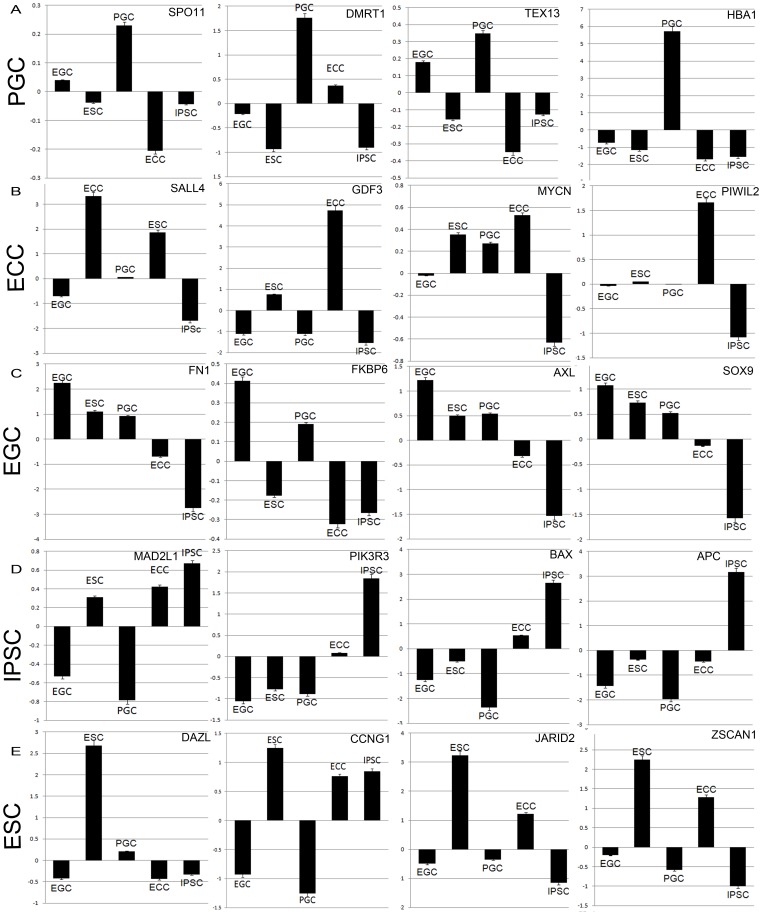
Identification of potential signature genes of PGCs, ECCs, EGCs, IPSCs, and ESCs.The vertical axis of each graph shows the log ratio of the expression data relative to the population mean. (A) Genes that are up-regulated in PGCs include (A) SPO11, DMRT1, TEX13, and HBA1. (B) Genes up-regulated in ECCs include SALL4, GDF3, MYCN, and PIWIL2. (C) Genes up-regulated in EGCs include FN1, FKBP6, AXL, and SOX9. (D) Genes up-regulated in IPSCs include MAD2L1, PIK3R3, BAX and APC
. (E) Genes up-regulated in ESCs include DAZL, CCNG1, JARID2, and ZSCAN1.